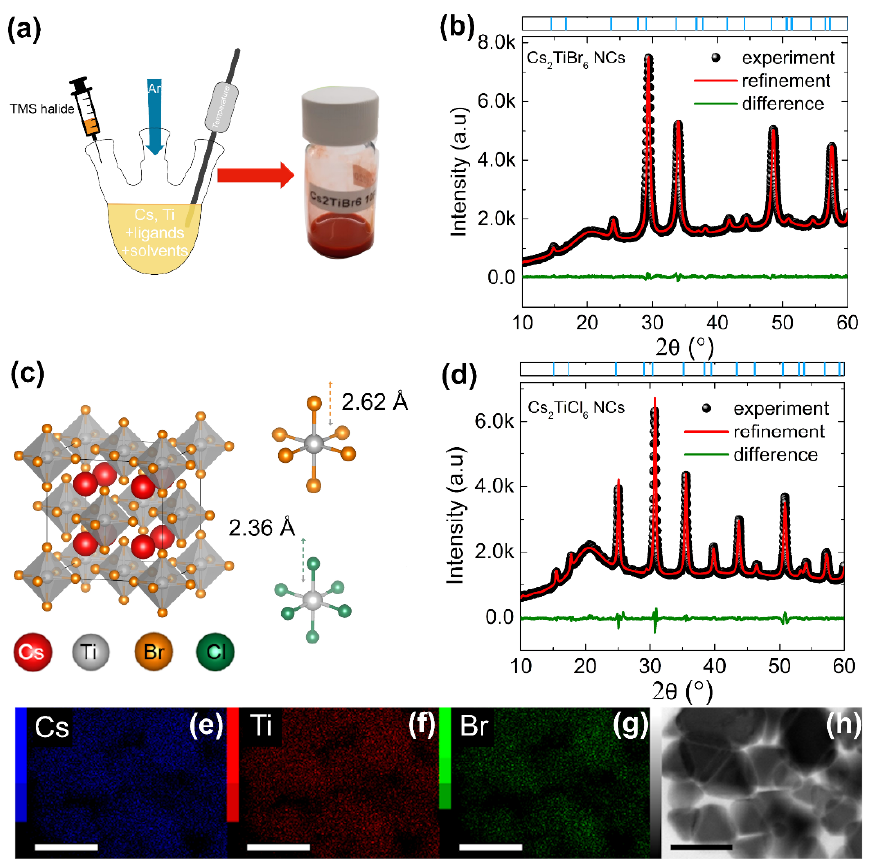
Figure 1. Synthesis and crystal structure. ( a ) Schematic representation of NC synthesis: injection of TMS-Br into precursor solution at high temperature. ( b ) Experimental (black dots), refined (red line), and difference (green line) profiles obtained after the full-pattern Rietveld refinement of the Cs 2 TiBr 6 NC (synthesized at 185 °C without OlAm) XRD pattern. ( c ) The crystal structure of Cs 2 TiBr 6 , where red, grey, orange, and green spheres represent Cs, Ti, Br, and Cl atoms, respectively. Ti-Br and Ti-Cl octahedra, with the corresponding Ti-halide bond lengths, are also depicted. ( d ) Experimental (black dots), refined (red line), and difference (green line) profiles obtained after the full-pattern Rietveld refinement of the Cs 2 TiCl 6 NC (synthesized at 185 °C) XRD pattern. ( e – g ) EDS elemental (Cs, Ti, and Br) maps of the Cs 2 TiBr 6 NCs and ( h ) the corresponding STEM image. The scale bar is 100 nm.